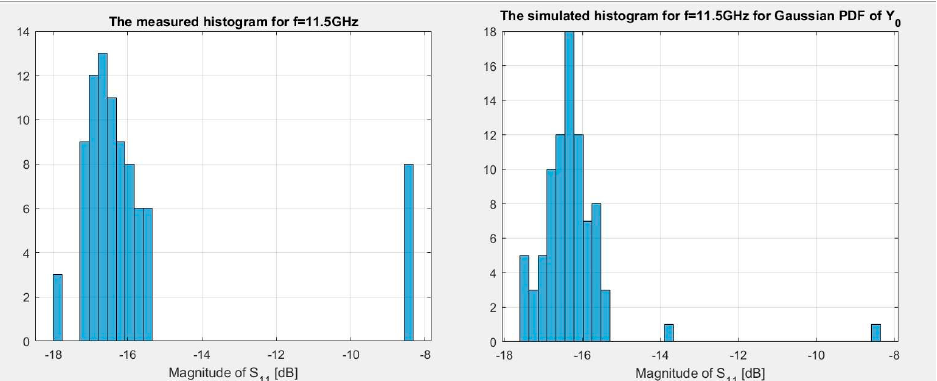
Figure 6. Histogram of | S 11 | obtained from the measurements and simulation results for σ y0 = 0.025 mm for antenna design from Figure 2 for the frequency of 11.5 GHz.